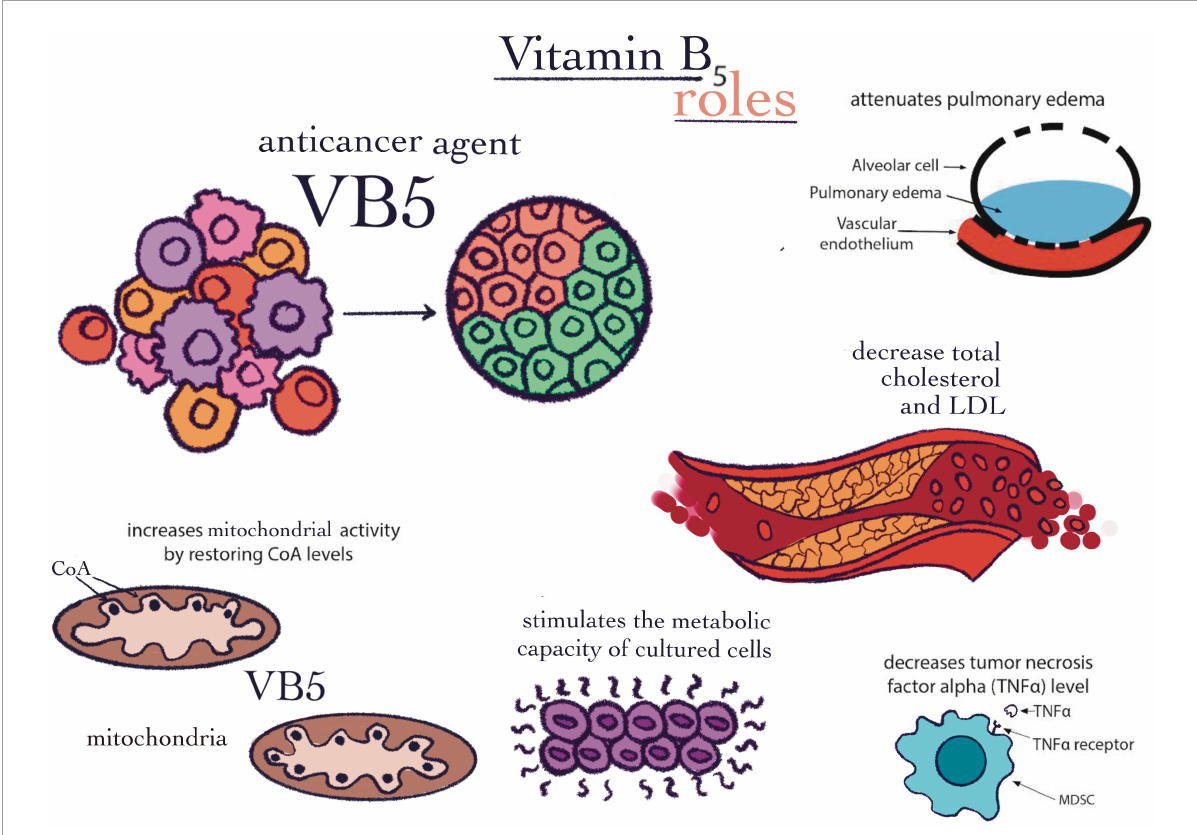
FIGURE3 Vitamin B5 roles. The following effects were presented: Anticancer agent, attenuates pulmonary edema, decrease total cholesterol and LDL, increases mitochondrial activity by restoring CoA levels, stimulates the metabolic capacity of cultured cells, and decreases tumor necrotic factor-alpha (TNF- α )